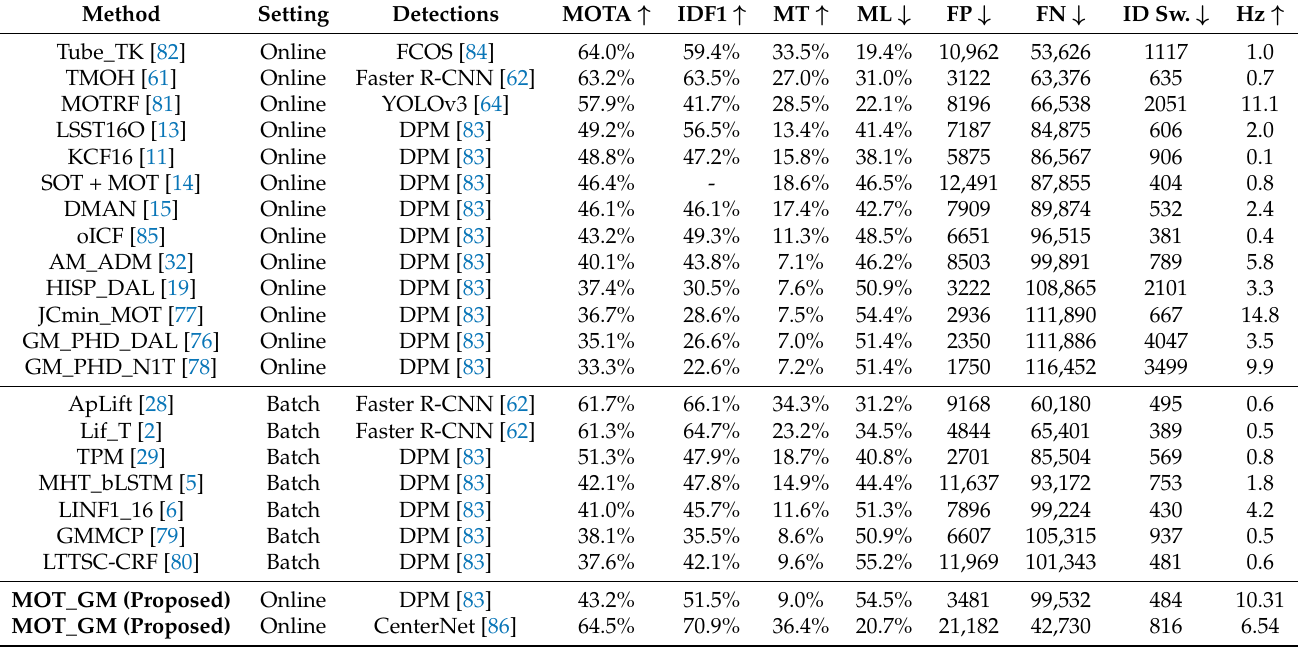
Table 1. Comparison with recent multi-object tracking methods on the 2016 MOT benchmark chal- lenge. Results are sorted by the setting and MOTA score. More details can be found in the MOT benchmark website (https://motchallenge.net/results/MOT16/, accessed on 28 September 2022). DPM [83] denotes original public detections provided by MOT16. However, detections marked with other names (e.g., FCOS, Faster R-CNN, etc.) mean the refined detections by applying the corresponding